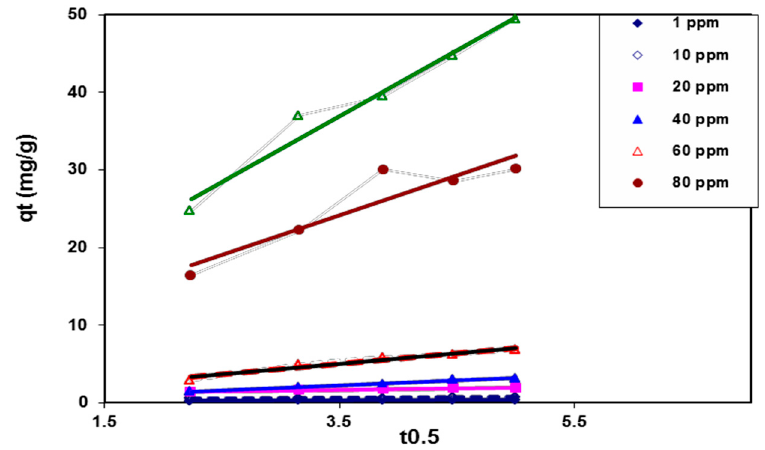
Figure 10. Intra-particle diffusion kinetic model for BV 14 dye adsorption onto the chemically modified nanofibers.